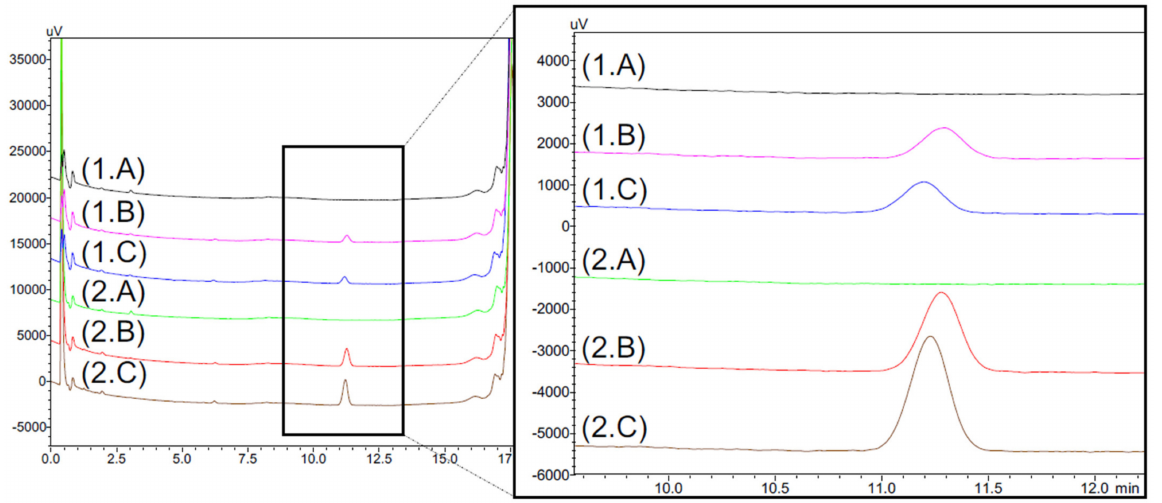
Figure 8. Chromatograms of excipients formulation (TAC-free) of 1 mg/mL (1) and 0.2 mg/mL (2) formulations without contact with the silicone membrane of the ophthalmic multidose delivery system (A) compared with formulations which remained in contact one day (B) and seven days (C) with the silicone